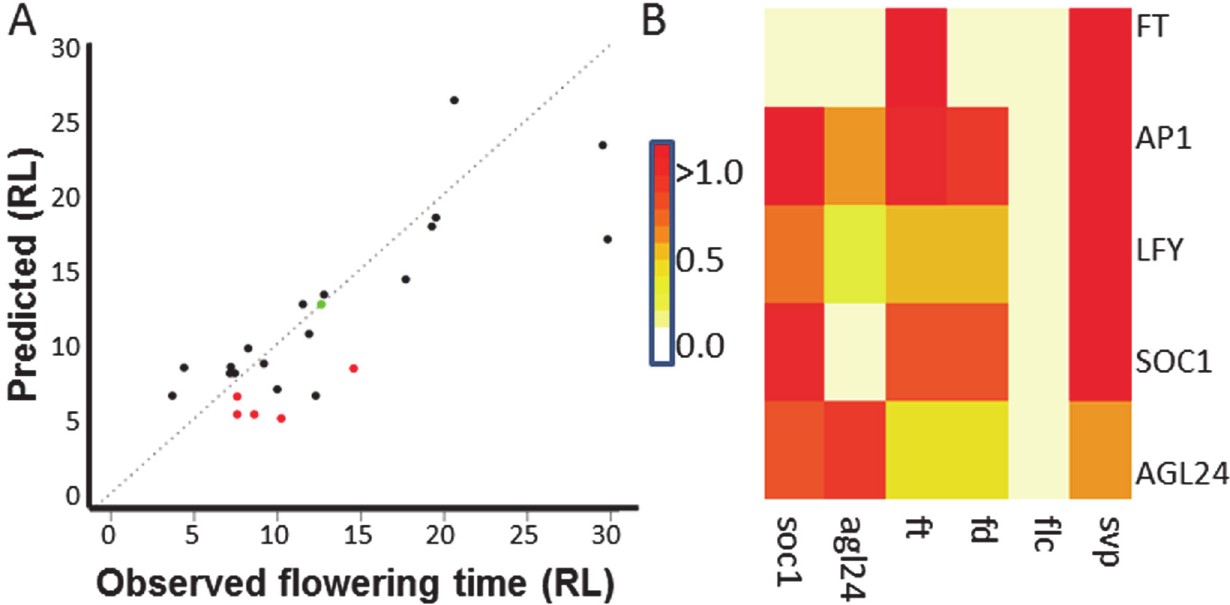
Fig 3. Model predictions and experiments in various mutant backgrounds. (A) Predicted vs. experimentally observed flowering time for mutants used in training the model (black) and for double mutants used for validation (red). Wild type flowering time is indicated in green. RL, rosette leaves: the more rosette leaves, the later flowering. (B) Prediction of expression changes; total change in expression over the simulated time-course is calculated, normalized against wild type; absolute value is reported to focus on the magnitude of the predicted expression change. Horizontal axis, mutants; vertical axis, genes for which expression change in mutant background is simulated. Note that FLC and SVP are not regulated by other genes in the model and hence, their expression level does not change upon any mutation. For comparison between predictions and experiments, see Figures C and D in S1